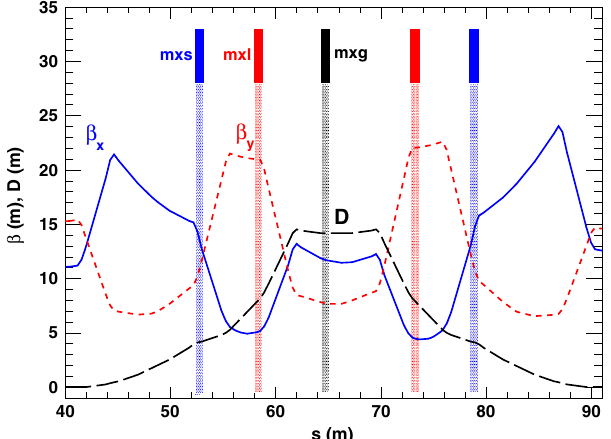
FIG. 1. Variation of the beta functions β x and β y along with the dispersion D as a function of the distance s along the reference orbit through the first arc of the COSY storage ring. The opposite arc is similar. The locations of the MXS, MXL, and MXG sextupole magnets are indicated with different colors. All of the magnets in each of these three families (in both arcs) are wired in series and controlled with a single setting of the